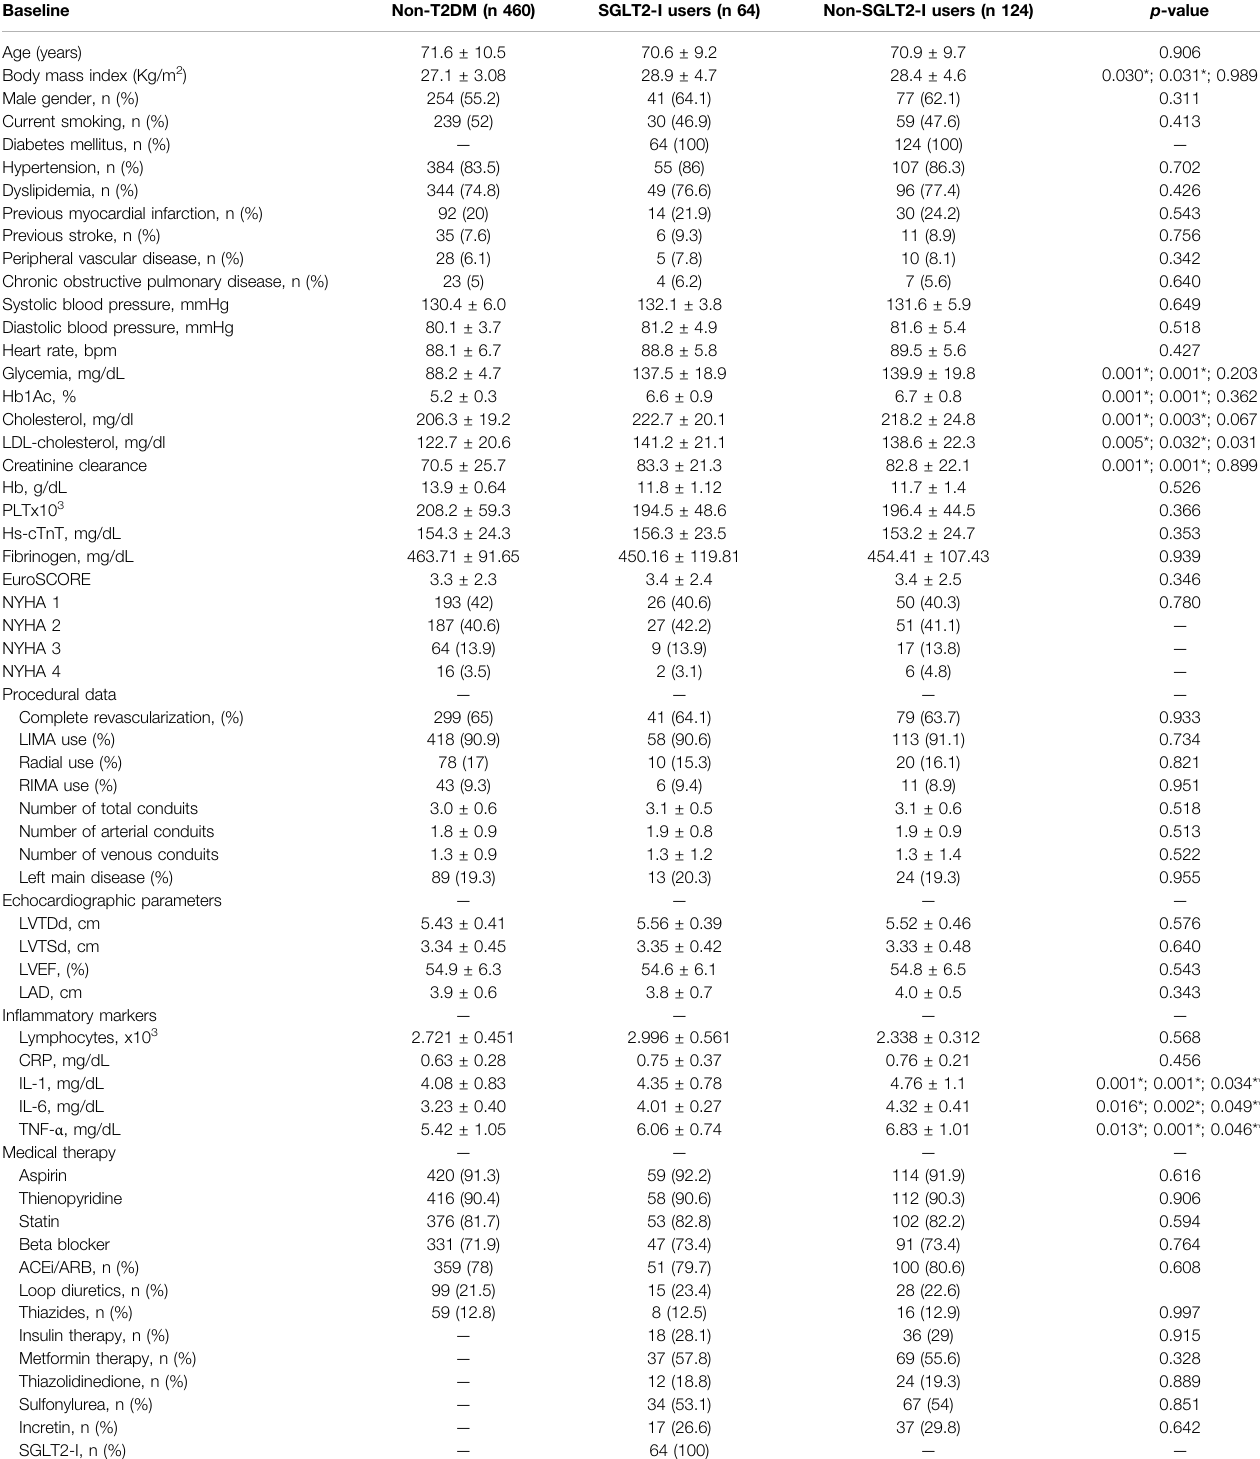
TABLE 1 | Characteristics of study population at baseline.